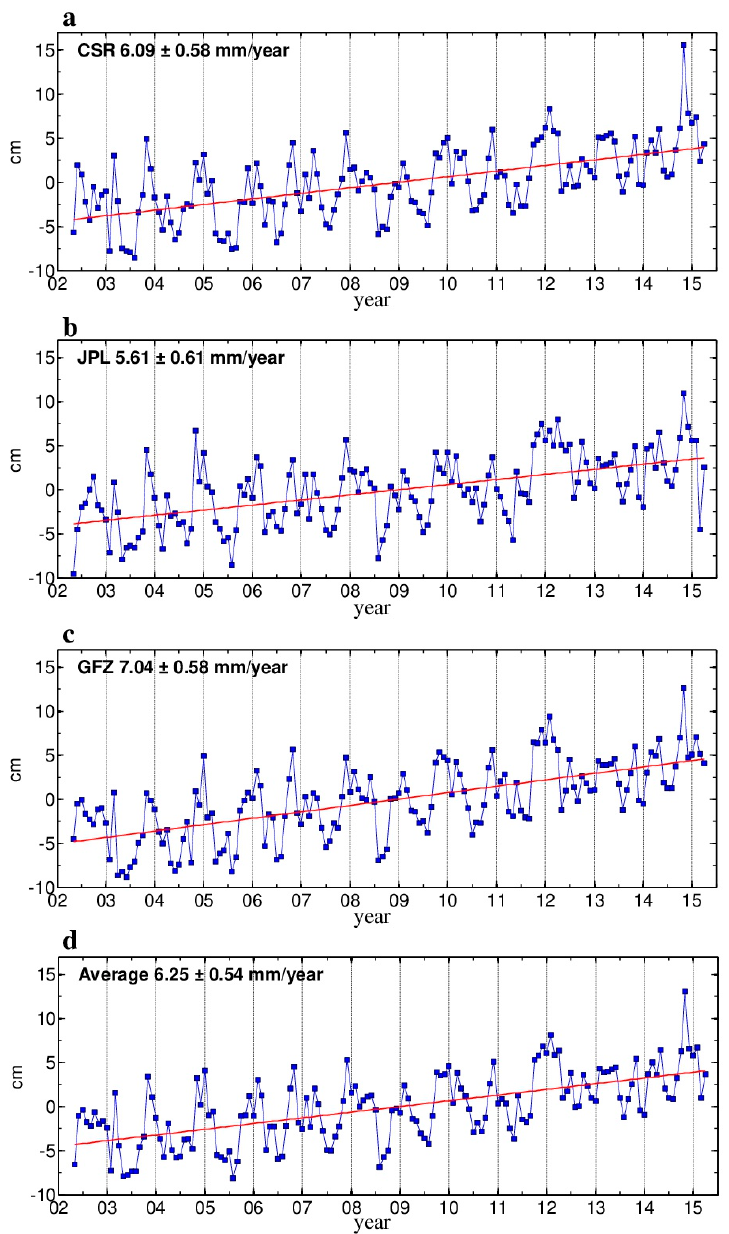
Figure 4. Monthly GRACE-derived EWHs (blue squares) over April 2002–March 2015 and rates (red line) from ( a ) CSR; ( b ) JPL; ( c ) GFZ and ( d ) the mean of the three. An EWH is the mean of the EWHs at the grids over 122–126°E, 27–32°N (the thick black dots in the dashed boxes in Figure 5a–c).